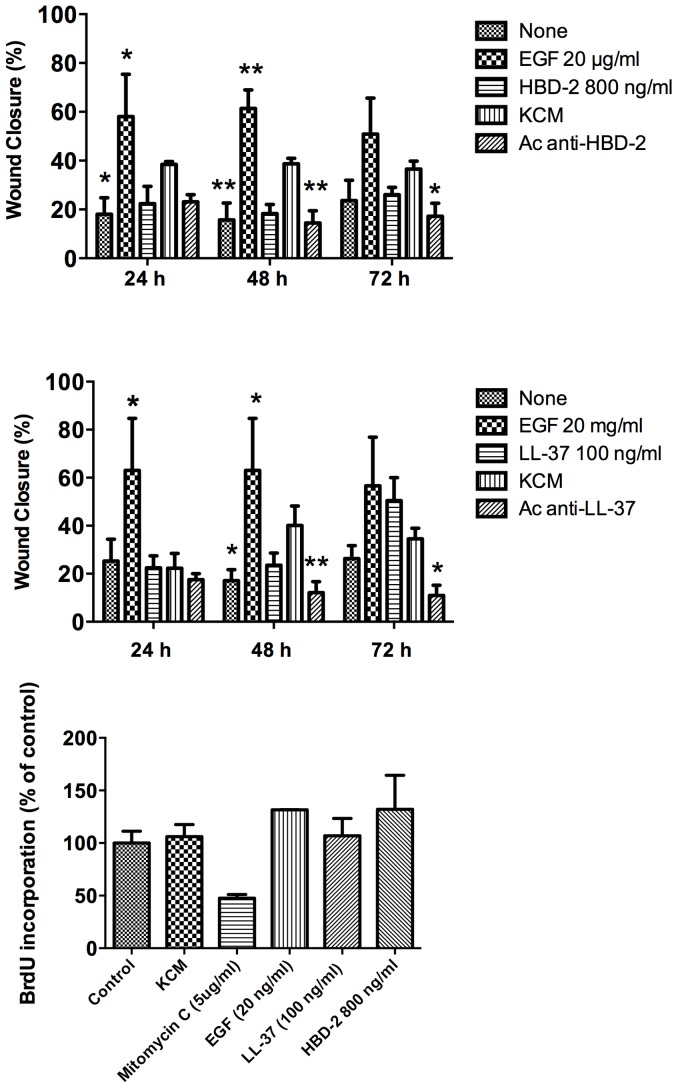
Keratinocyte-conditioned medium mediate proliferation and keratinocyte migration.Vitamin D- treated KCM from DFU were tested for cell migration induction. HaCaT cells were grown to confluence on 24-well tissue culture plates. Then each well was denuded by half from cells and re-coated with fibronectin, then we measured wound closure at 24, 48 and 72 hours post-incubation using as controls Epithelial Growth Factor (EGF), LL-37 or HBD-2, and the KCM with blocking antibodies either for HBD-2 (7A) or for LL-37 (7B). BrdU incorporation was used as an index of cellular proliferation (7C). Data are expressed as a percentage of the BrdU-positive cells (BrdU incorporation). Each value represents the median ± interquartile range. Values are the mean of 3 independent experiments. Asterisks show the treated groups with statistical difference when compared with KCM for each time point. * p<0.05, ** p<0.01.